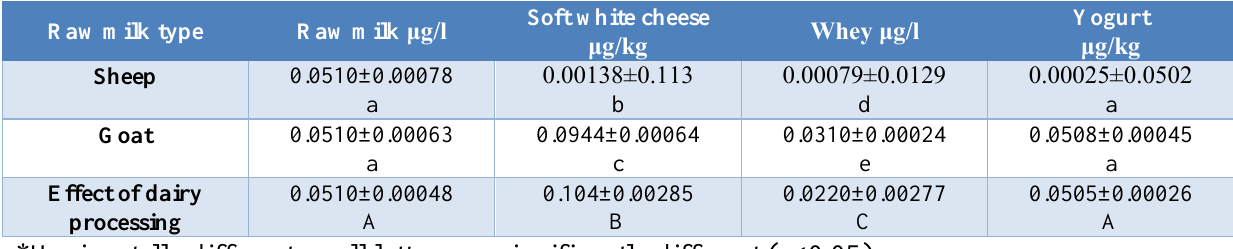
Effect of dairy